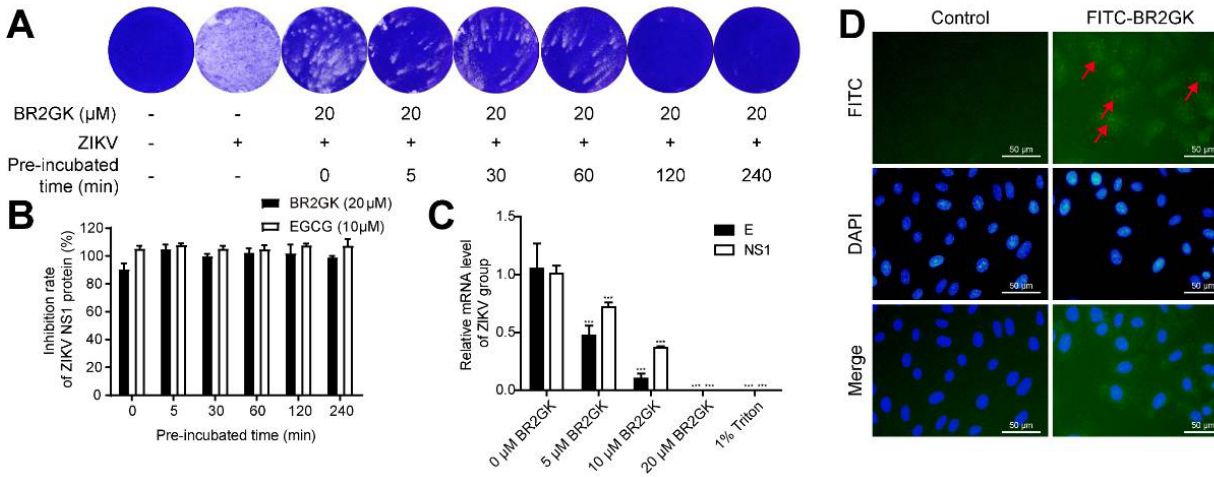
Figure 3. BR2GK directly inactivated ZIKV. ZIKV was pre-incubated with BR2GK for different times before infection; then, the plaque assay ( A ) and cell-based ZIKV immunodetection assay ( B ) were used to evaluate the infection rate of ZIKV. ( C ) BR2GK-treated ZIKV was digested by micrococcal nuclease; then, the degradation of released genomic RNA was detected by qRT-PCR. ( D ) Fluorescence microscopy was used to detect BR2GK (as indicated by arrows) entering Vero cells. Experimental data are expressed as mean ± SD ( n = 3), *** p < 0.001 compared with the control group.